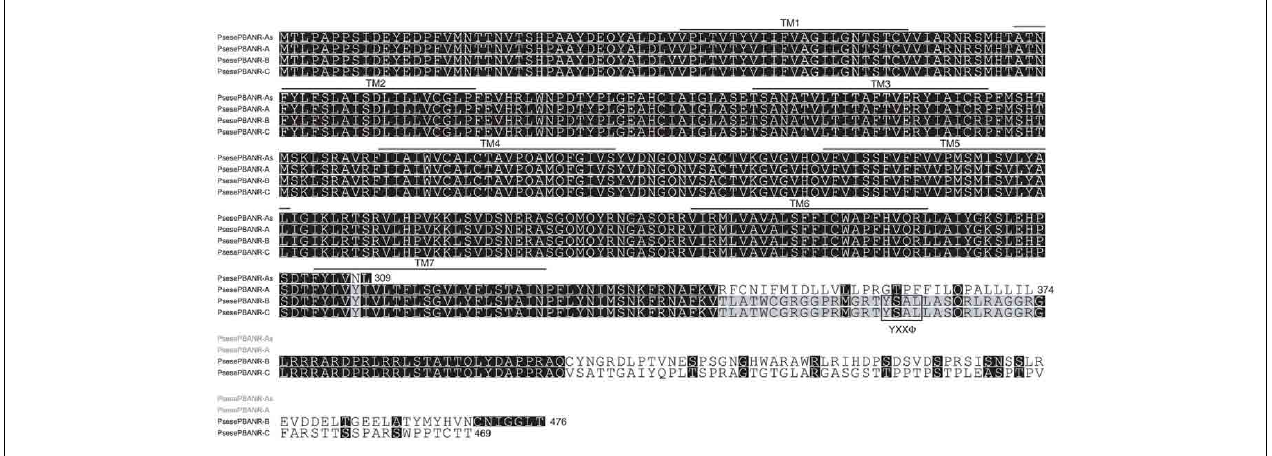
MAFFT v6.814b (Katoh et al., 2002) with certain gaps removed. Species abbreviations are per National Center for Biotechnology Information/Swiss Prot: Psese, Pseudaleti separata.